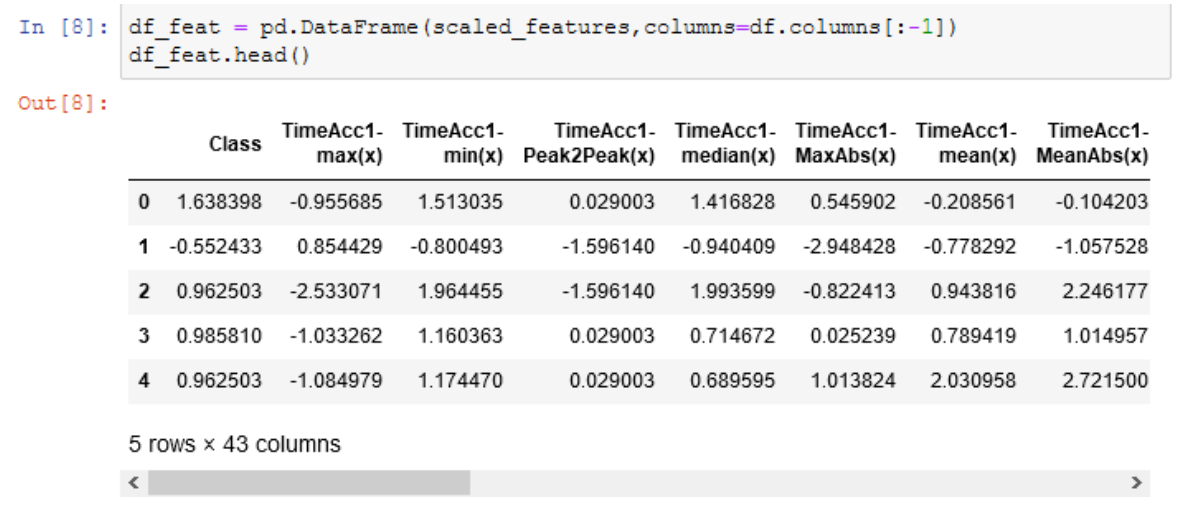
Figure 7. Results of the standardization step.